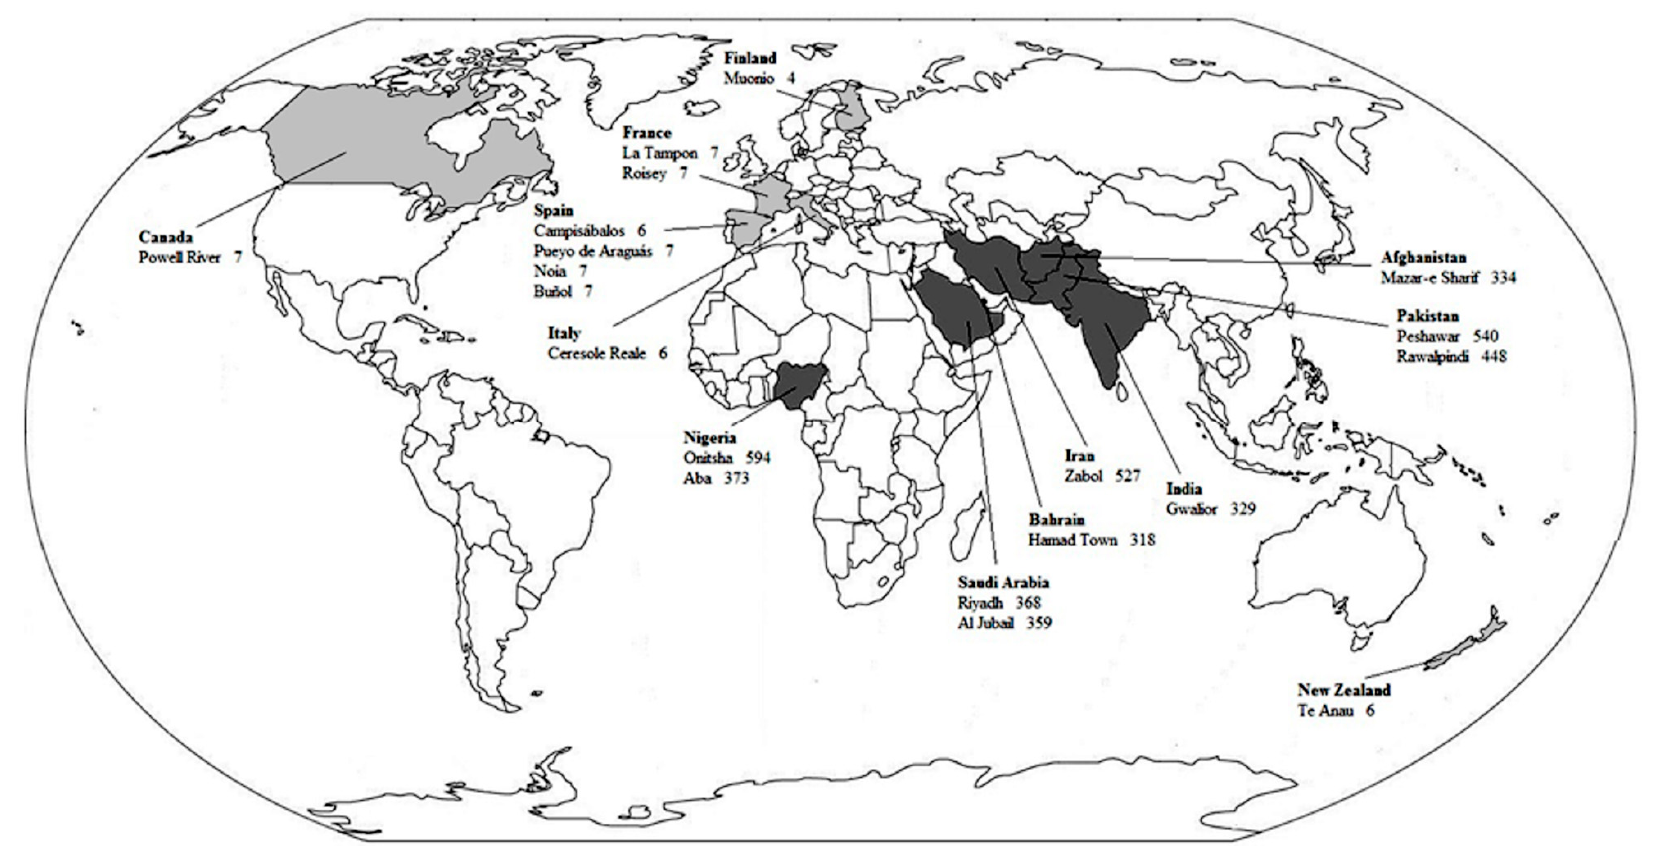
Figure 1. PM 10 annual means by the 10 cleanest and 10 dirtiest cities. Countries with the cleanest cities are in light gray. Countries with the dirtiest cities are in dark gray. Adapted from the WHO data on the average annual concentration of PM 10 per city (data from http://www.who.int/phe/health_topics/outdoorair/databases/en/) [14].